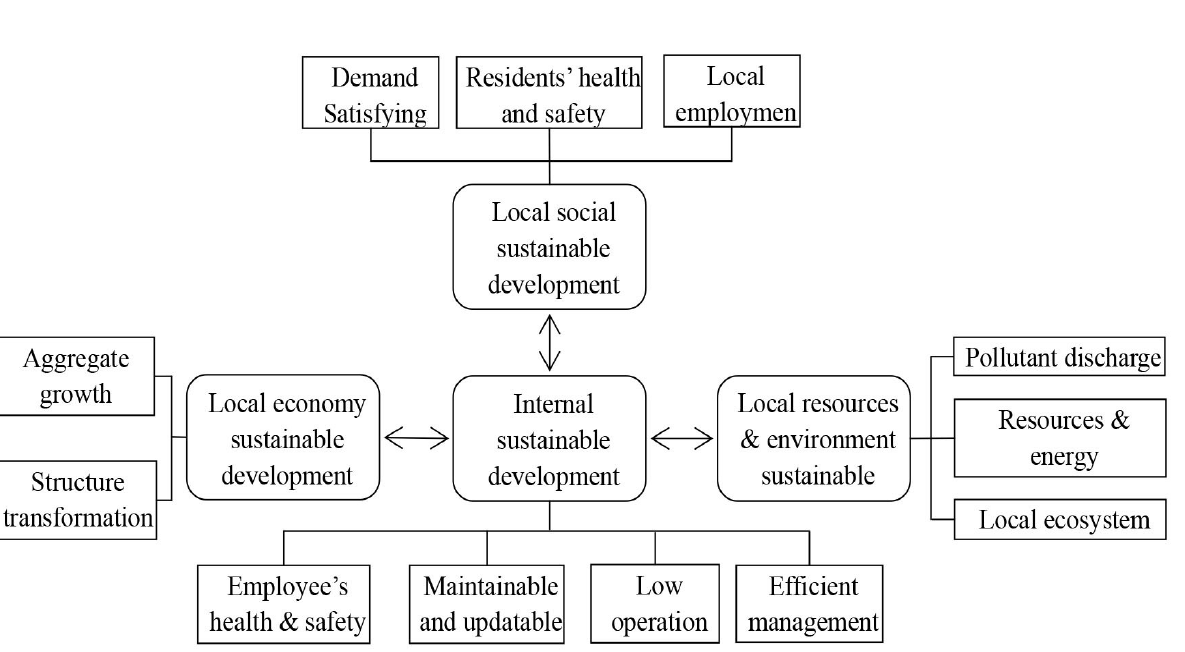
Figure 1. Analysis diagram of infrastructure